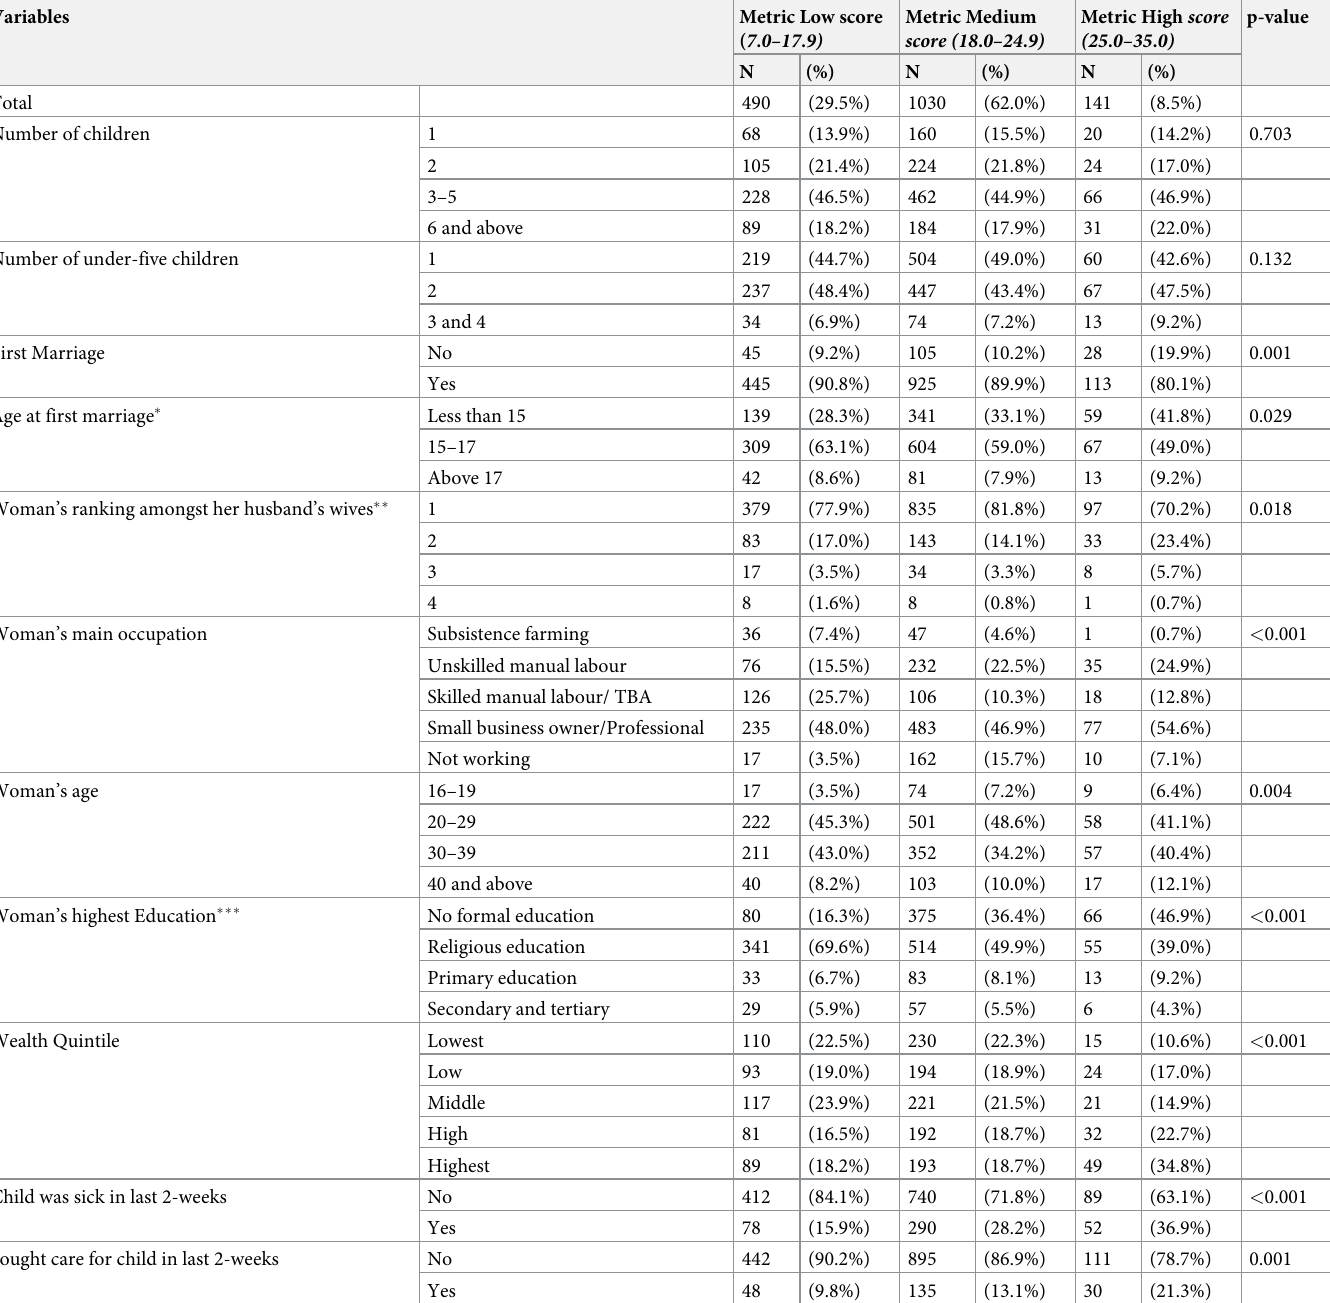
Table 2. Summary of well-being score, according to key compound and woman